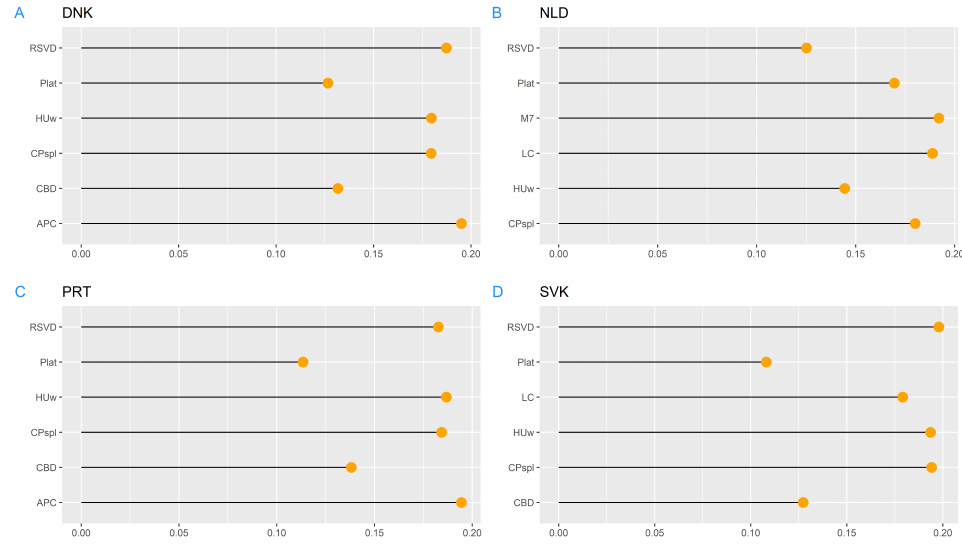
Figure 1. Model confidence set and BME model weights per country, total population. Notes: DNK = Denmark; NLD = The Netherlands; PRT = Portugal; SVK =